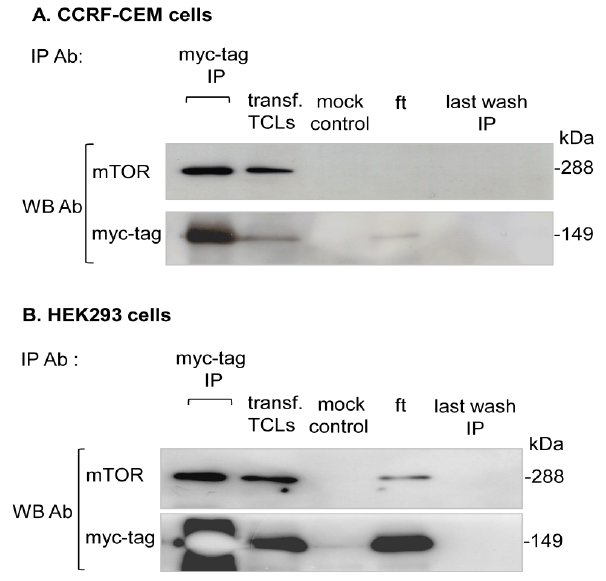
Figure 2. Purification of the myc-tag raptor component of mTORC1: ( A ) CCRF-CEM or ( B ) HEK293 cells were transiently transfected with myc-tag raptor pRK5 plasmid. After 48 h of transfection, cells were lysed, and the myc-tag raptor component of mTORC1 was immunoprecipitated with monoclonal myc-tag antibody conjugated beads. Transfected (transf.) HEK293 total cell lysates (TCLs), mock, flow through (fl) wash and last IP